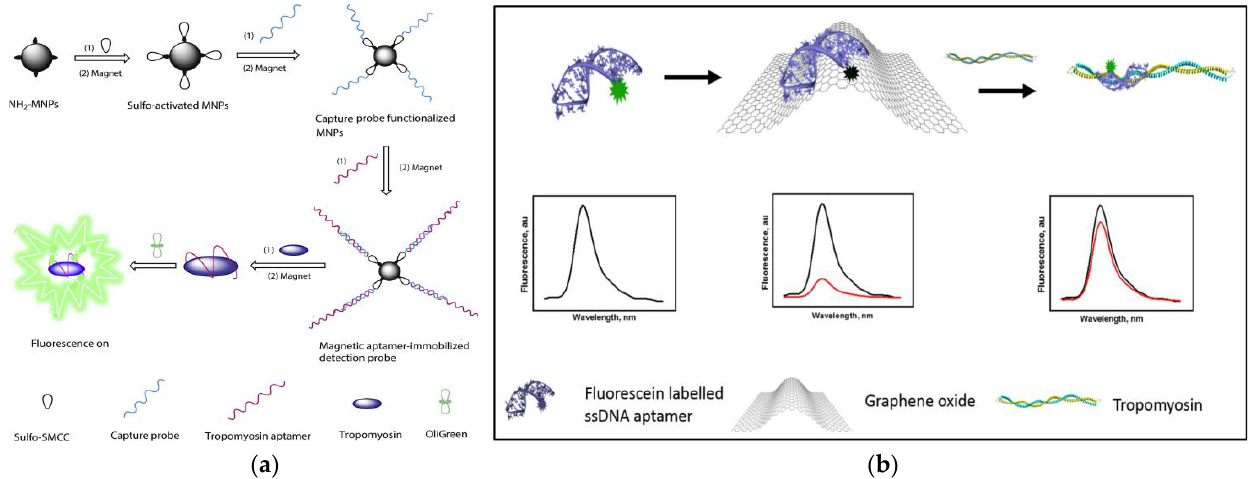
Figure 2. ( a ) Schematic of preparation of magnetic-assisted fluorescent aptamer for tropomyosin detection. Reproduced with permission from [154]. Copyright Sensors and Actuators B-Chemical, 2018. ( b ) Schematic of graphene oxide-based fluorescent aptamer biosensor for TM detection (A: Changes in the fluorescence intensity of the aptamer released from the GO surface; B: The linear correlation of the fluorescence intensity of TMT2 (at 515 nm) with the concentration of TM. Reproduced with permission from [156]. Copyright Food Chemistry, 2020.